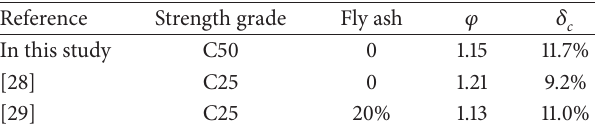
Table 8: Values of the parameters of the model under various